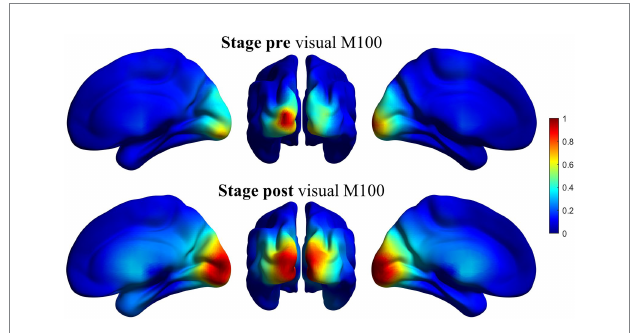
FIGURE 2 Representation of the source reconstruction of the primary visual response using the beamformer spatial filter for beta band. Grand average of the activity for all the participants. Left column: Ventral view of the right hemisphere. Middle column: Posterior view of both hemispheres. Right column: Ventral view of the left hemisphere. Superior line: pre-stage activity. Inferior line: post-stage activity. The activity is correctly reconstructed in occipital areas, mainly calcarine fissure. Similar results (not shown here) were obtained for the rest of the